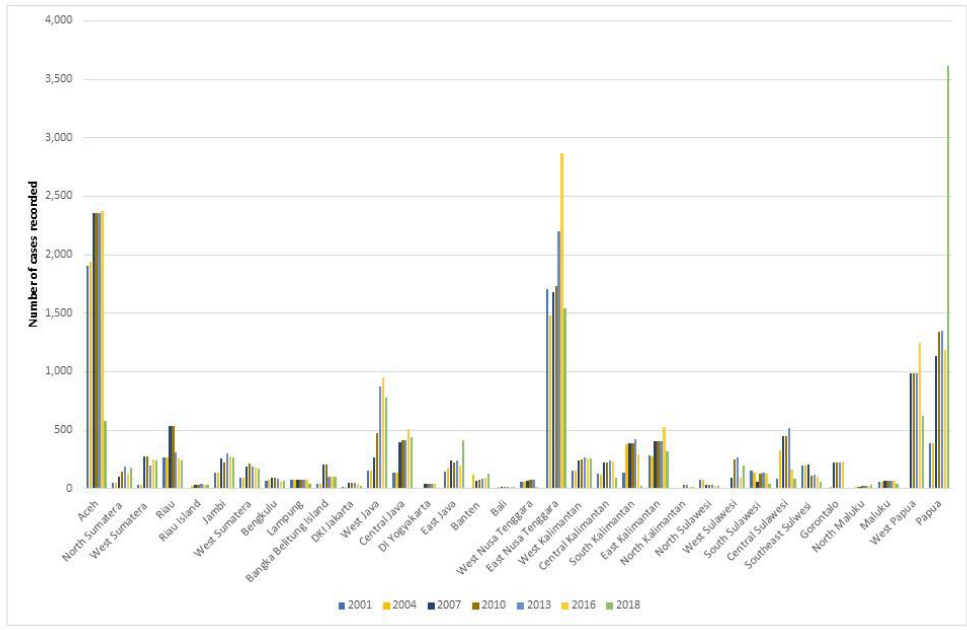
Figure 2. The Number of Chronic Lymphatic Filariasis Cases in 34 Provinces in 2001, 2004, 2007, 2010, 2013, 2016 and 2018.